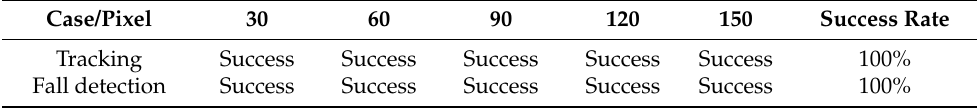
Table 4. The success rate with respect to synthetic illumination